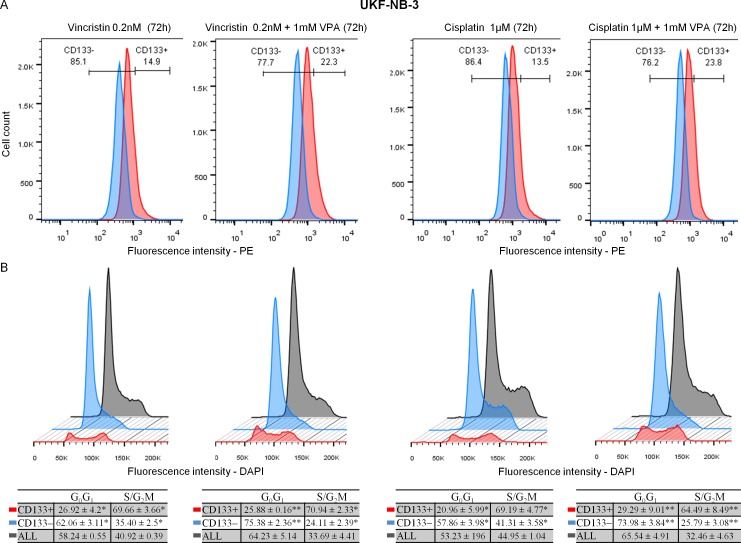
Changes of CD133 expression and cell cycle in VPA combined therapy at 72 hrs.(A) Increased CD133+ cells in VPA combined therapy. Blue—isotype control (IgG2b-PE); red—CD133 expression detected by 239C3 (CD133/2) antibodies. (B) CD133+ cells were mainly located in the S and G2/M phases, while CD133− were mainly present in the G0/G1 phases during treatment with cytostatics or in combination with VPA.